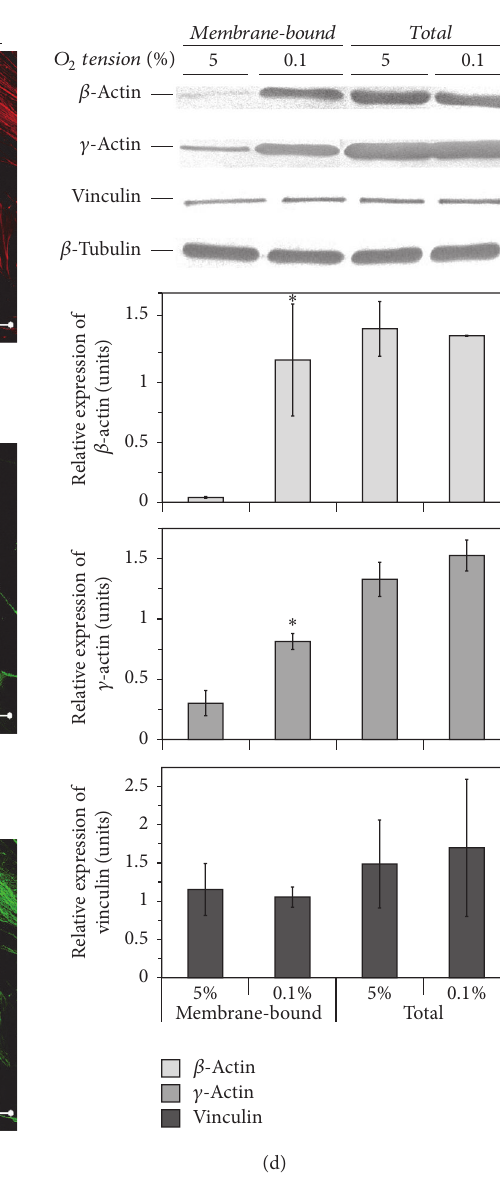
Figure 4: The effects of hypoxic stress on cytoskeleton organisation of tissue O 2 -adapted adipose tissue-derived mesenchymal stromal cells (ASCs). ((a)-(c)) Representative images of phalloidin staining (a) and immunofluorescent labelling of ASCs for vimentin (b) and 𝛽 -tubulin (c) before and after hypoxic stress (0.1% O 2 , 24 h) ( 𝑛 = 3 ). Scale bar is 50 𝜇 m. (d) Expression of 𝛽 -, 𝛾 -actin, 𝛽 -tubulin, and vinculin in total and membrane protein extracts obtained from ASCs before and after short-term hypoxic stress (mean + standard deviation, ∗ 𝑝 < 0.05 , 𝑛 = 3